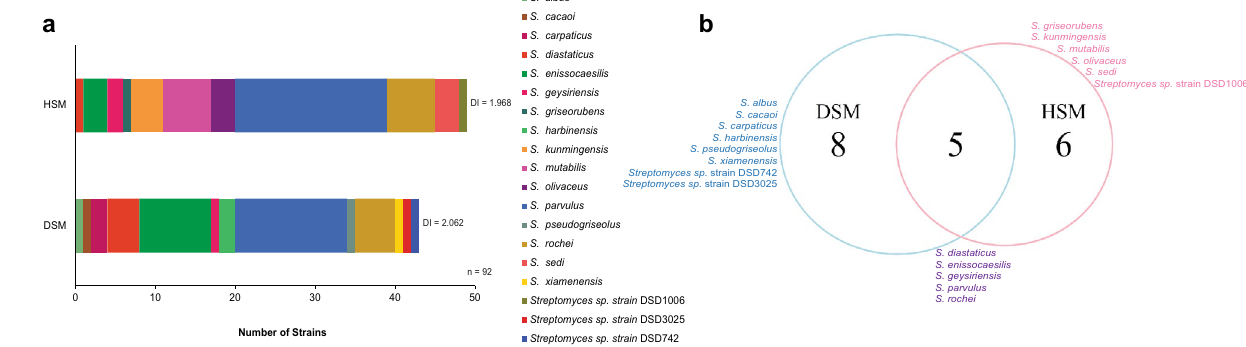
Figure 4. Diversity of antibiotic-producing Streptomyces using culture-dependent isolation techniques, heat shock method (HSM) and dry stamp method (DSM) . ( a ) Bar graph showed the number of active